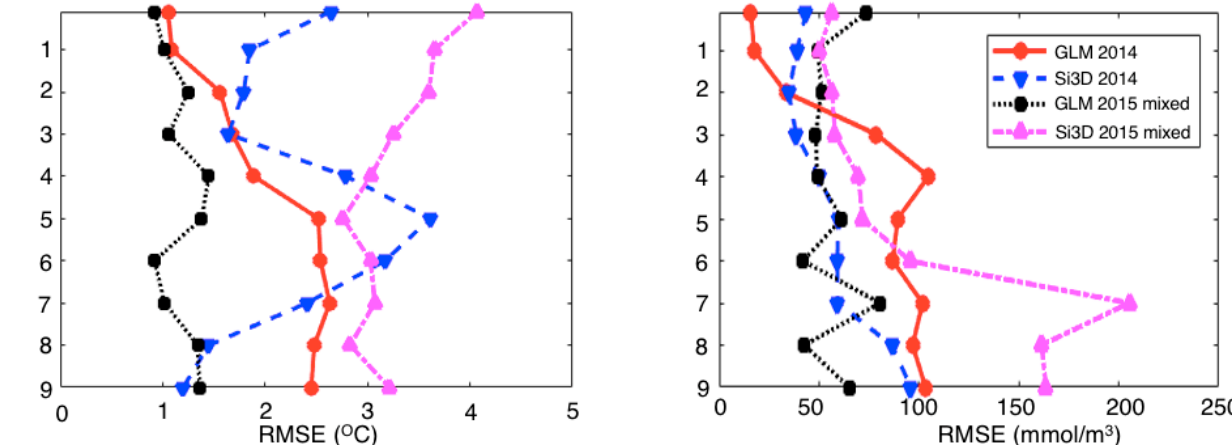
Figure 4. Profiles of the RMSEs of the temperature (left) and DO (right) RMSEs of the 1-D and 3-D models for 2014 and the mixed period of 2015.